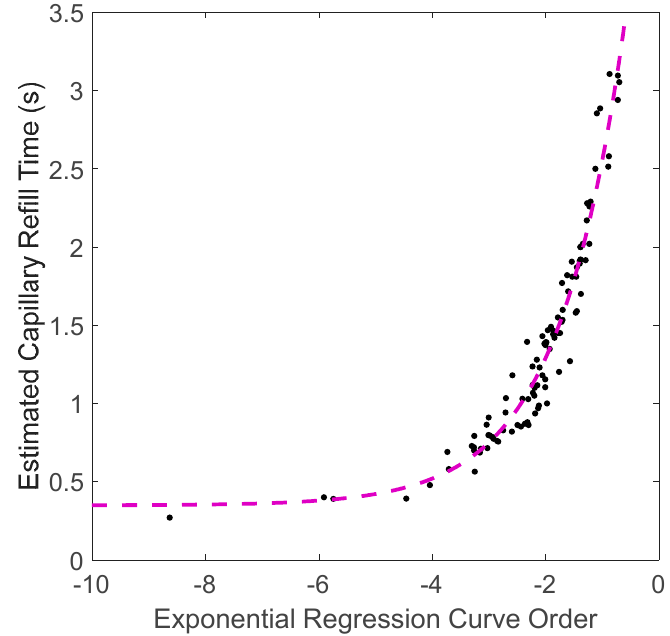
Figure 8. Relationship between the exponential regression curve order and the estimated capillary refill time. The black dots represent the estimated CRT for each refilling process. The purple dashed line is a fit through the data, which indicates an exponential relationship between regression orders and estimated CRT.